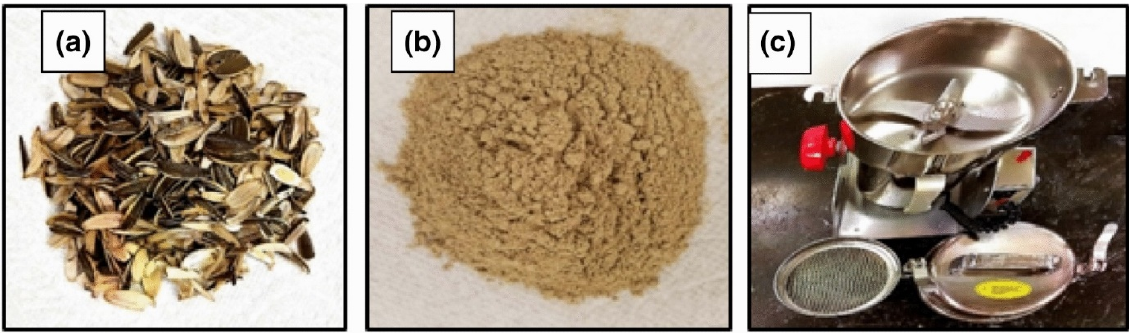
Figure 3. ( a ) Black sunflower shell raw waste converted into ( b ) powdered form using ( c ) a food processor [51].